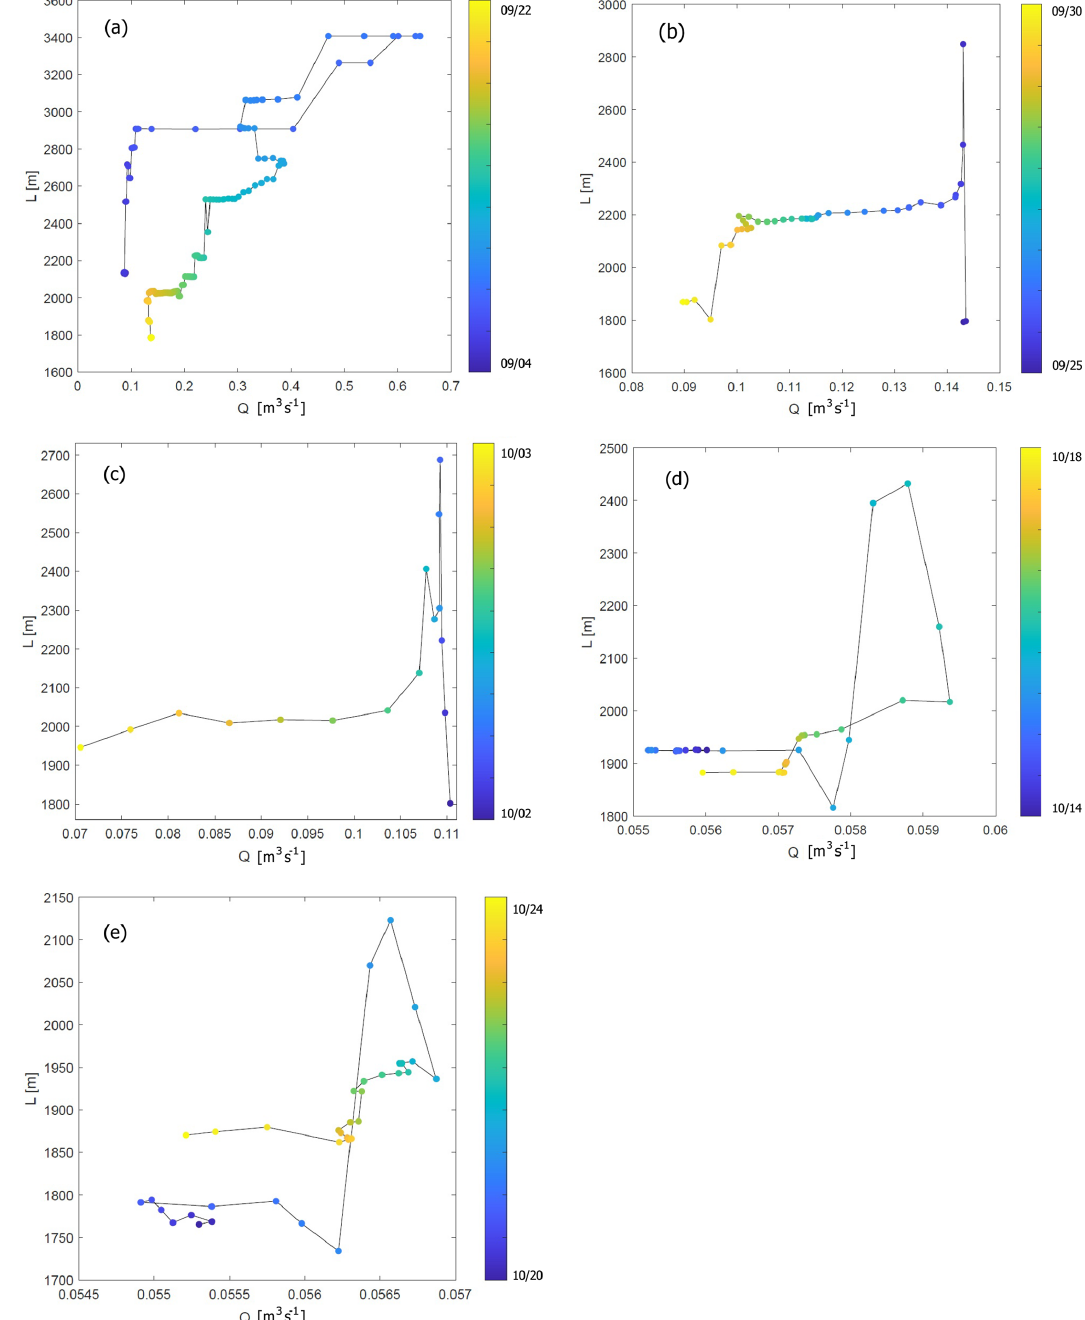
Figure E1. Plots of discharge and active length during individual events across the study period, as indicated in Fig.